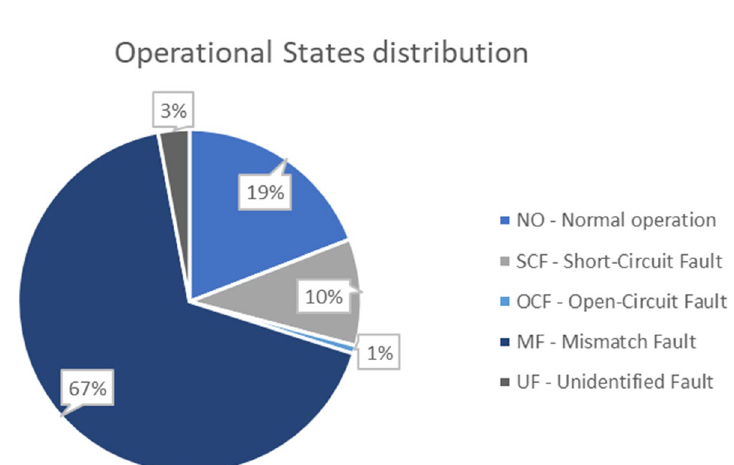
Fig. 4 Distribution of operational states within the